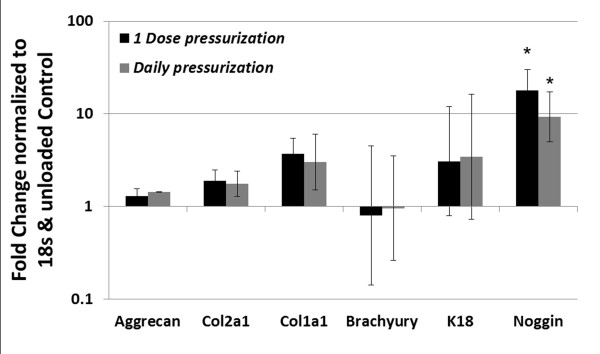
Gene expression for notochordal cell phenotypic markers. Quantitative reverse transcription real-time polymerase chain reaction was performed to assess fold-changes in gene expression in the1 Dose and Daily pressurization groups normalized to unloaded controls and housekeeping gene 18s. No significant changes were observed in Brachyury (T), K18, or matrix proteins (Aggrecan and Col1a1 and Col2a1), but there was a significant increase in Noggin expression with the Daily and 1 Dose load groups compared with the unloaded Control group (*P < 0.05).